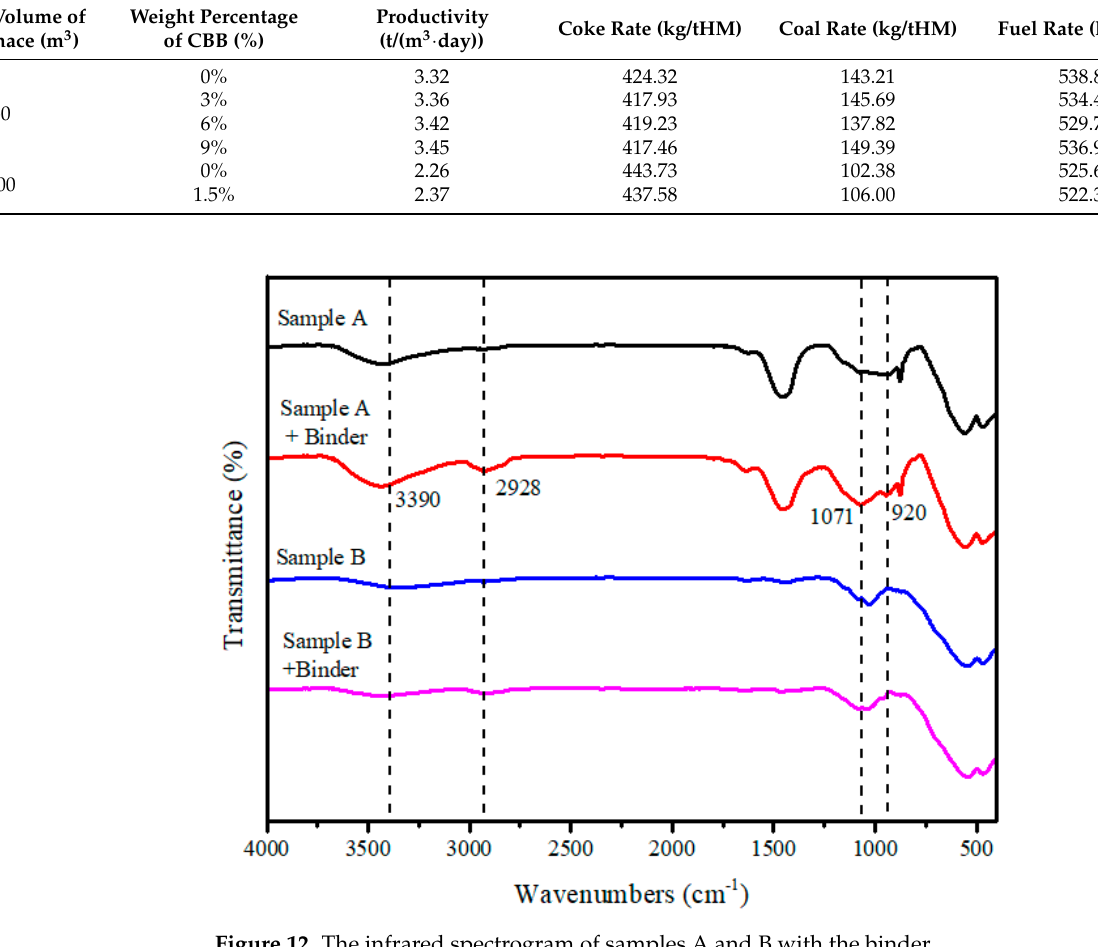
Table 4. Effect of return fines of CBBs on the performance of two blast furnaces with different effective volume.